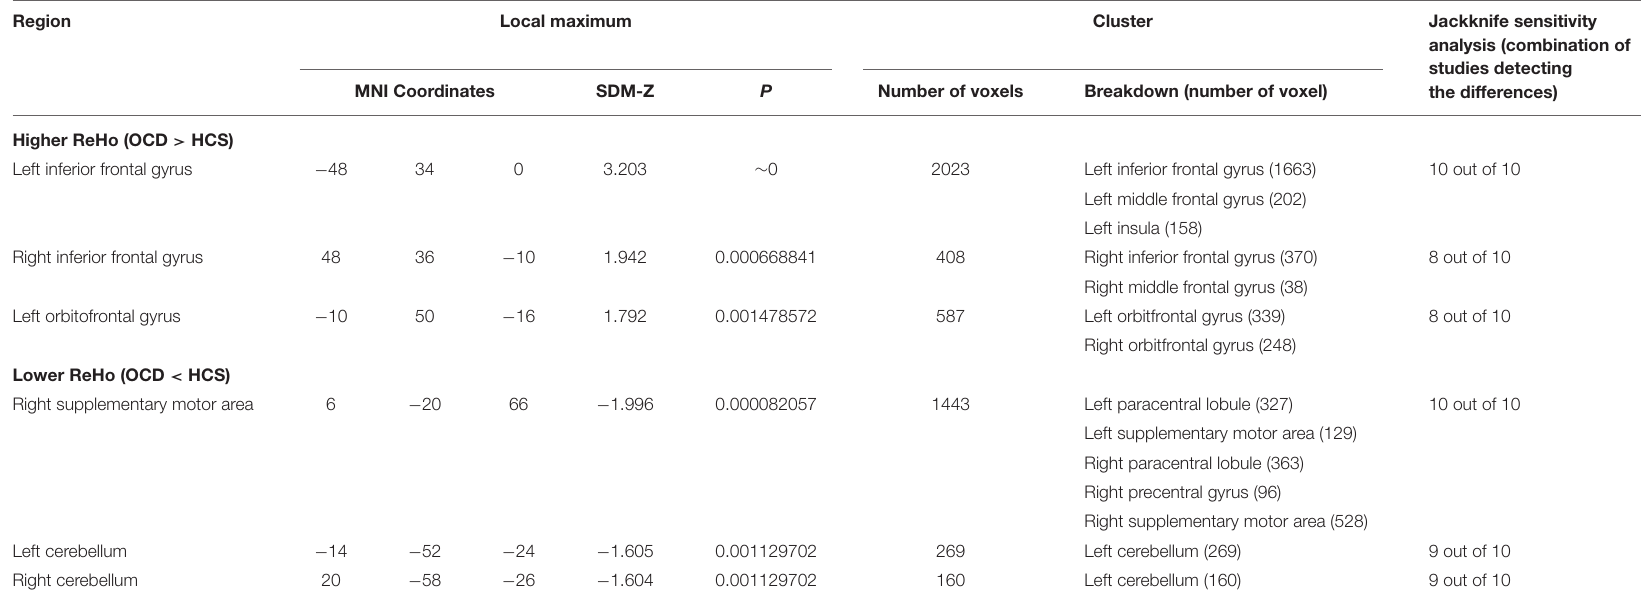
TABLE 3 | Statistical concurrence observed across ReHo studies on OCD. Region Local